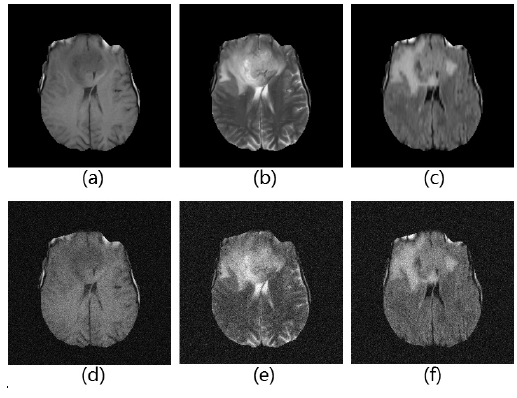
Fig. 3. MR images: (a) T1-weighted; (b) T2-weighted; (c) Flair; (d) Rician noise of SNR =10 on (a); (e) Rician noise of SNR =10 on (b); (f) Rician noise of SNR =10 on